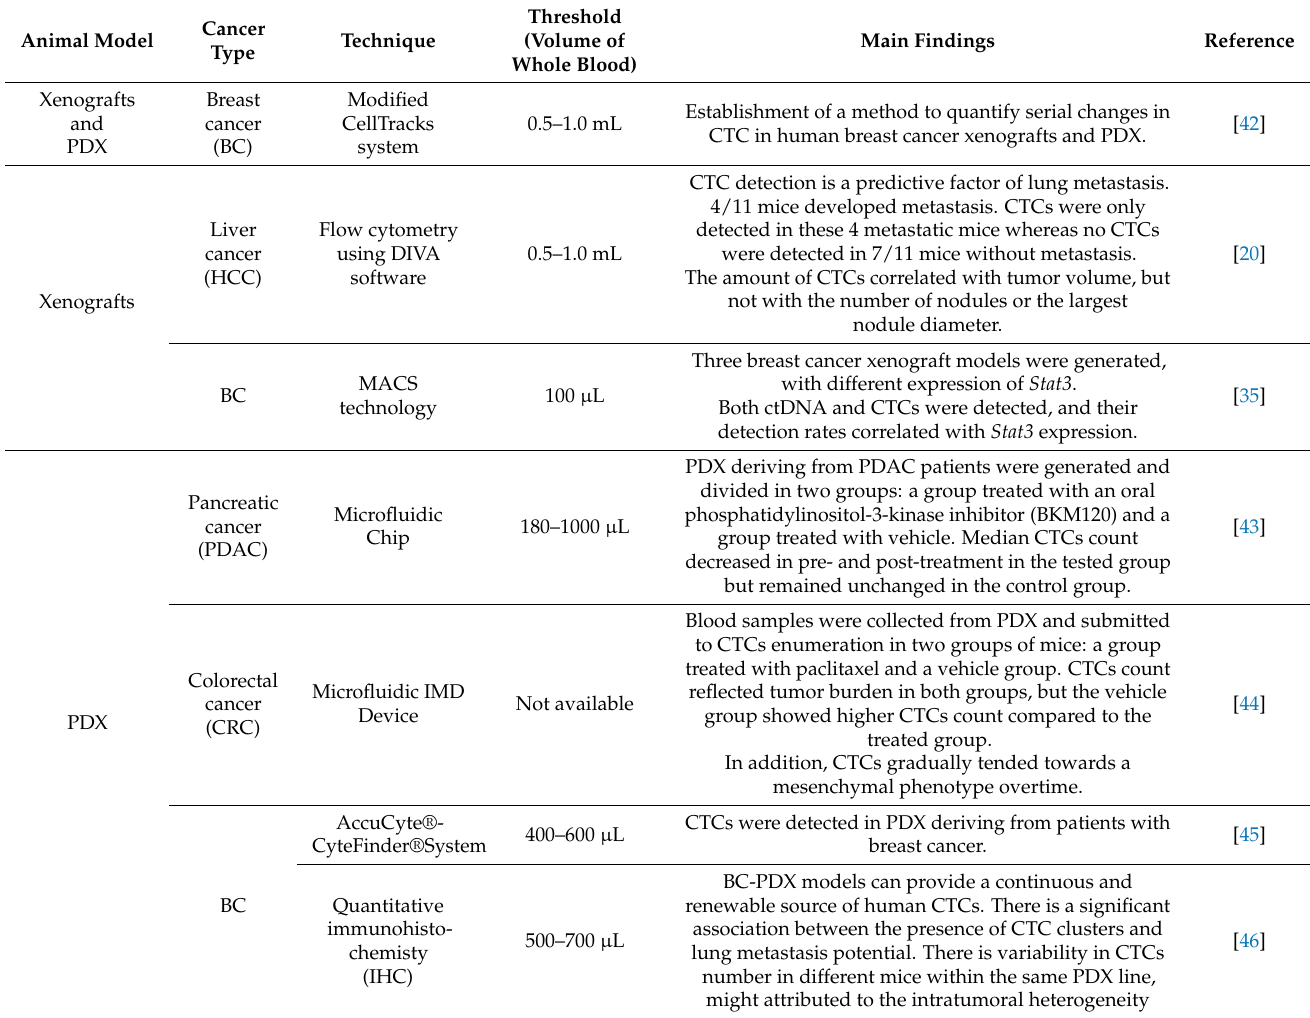
Table 2. Summary of studies investigating CTCs in basic